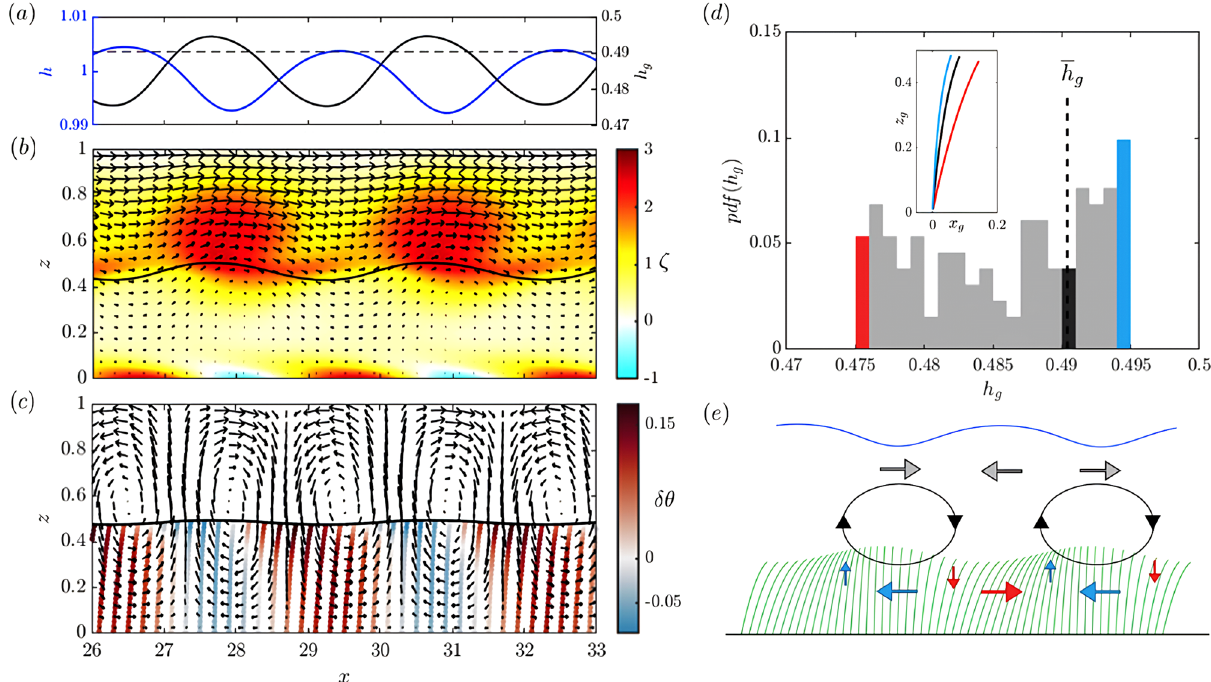
Figure 5. Instantaneous plots at t = 500 , for the ( a ) surface height h (solid blue line) and grass height h g (solid black line, with dashed line representing the reference steady-state height h g ), ( b ) contours of vorticity ζ and arrows representing the velocity field u , with the grass height perturbation (black line) amplified by a factor of 4. ( c ) Perturbation velocity field u ′ = u − u and grass blade representatives, with colors representing the angle of deflection with respect to the steady-state angle, δθ = θ − θ , in radians. ( d ) Histogram of the grass height distribution within the entire domain, with inset representing the blade shapes corresponding to minimum (red), maximum (blue), and steady-state (black) height (bin width = 0.001). ( e ) Schematic of how vortices (iso- vorticity contours) induce grass blade deflection, with arrows representing the velocity perturbation induced, and colors indicating how they deflect the grass blade locally. The blue line on top representing the